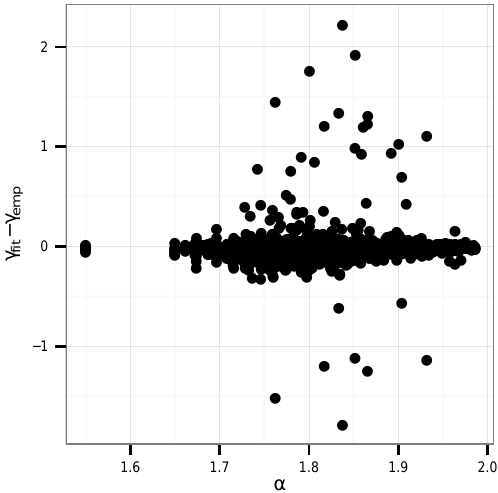
Figure 7. The difference between the parameter γ as fitted, and as predicted with correlations versus the tail parameter α . The few very large values are due to the largest scales, but generally the approximations appears to behave without bias or response to deviations from normal when α (cid:28)